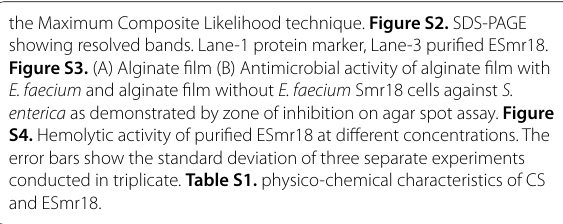
the Maximum Composite Likelihood technique. Figure S2. SDS-PAGE showing resolved bands. Lane-1 protein marker, Lane-3 purified ESmr18. Figure S3. (A) Alginate film (B) Antimicrobial activity of alginate film with E. faecium and alginate film without E. faecium Smr18 cells against S. enterica as demonstrated by zone of inhibition on agar spot assay. Figure S4. Hemolytic activity of purified ESmr18 at different concentrations. The error bars show the standard deviation of three separate experiments conducted in triplicate. Table S1. physico-chemical characteristics of CS and